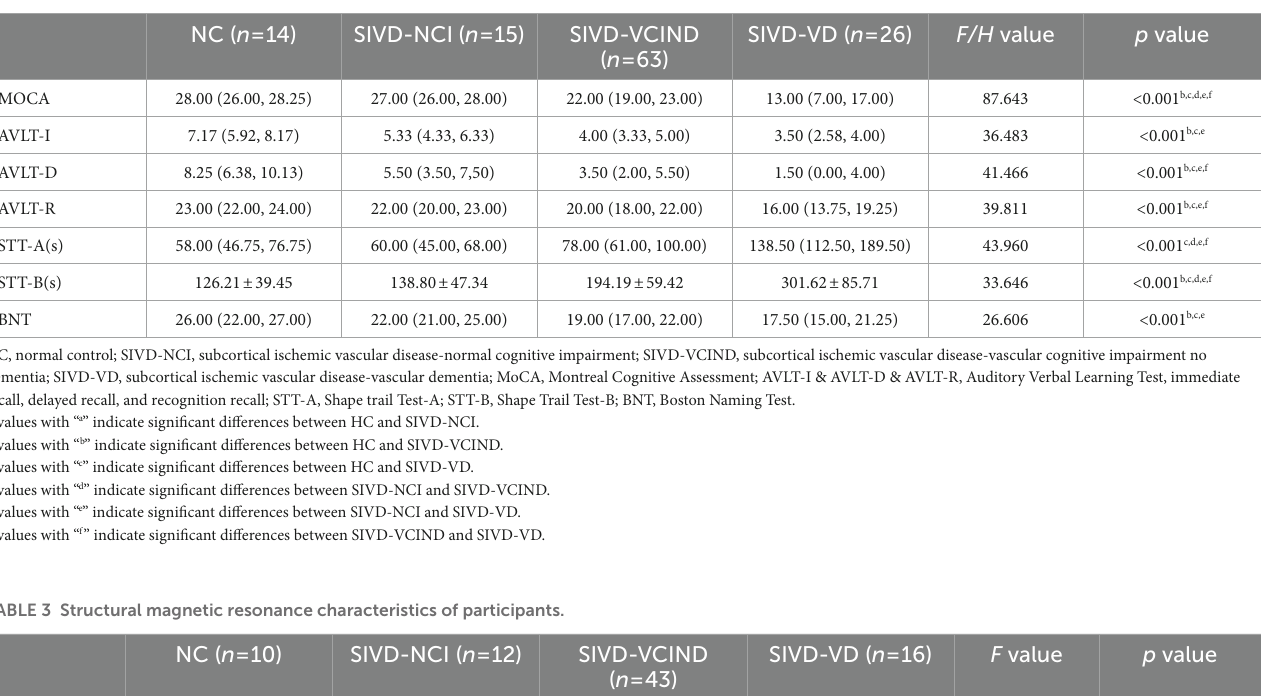
TABLE 2 Psychopsychological scale characteristics of participants.